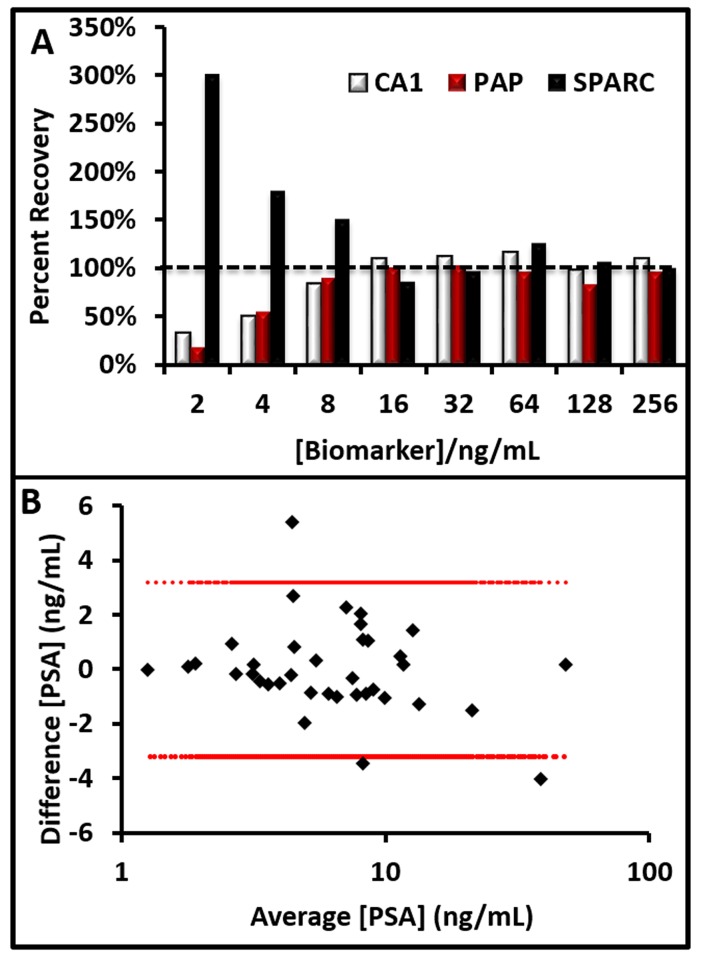
Serum Validation.
A) Percent recovery for three representative biomarkers. Matrix effects can either dampen signal (CA1, PAP) or inflate signal (SPARC). Ideal dilution factors were dependent on sensitivity of the assay and reference range of the biomarker (Table 1). Black dashed line indicates 100% spike recovery. B) Bland-Altman plot [38] validating specimen integrity of a subset (N = 35) of the clinical samples with high sample volumes. Red dashed line indicates 95% confidence interval.